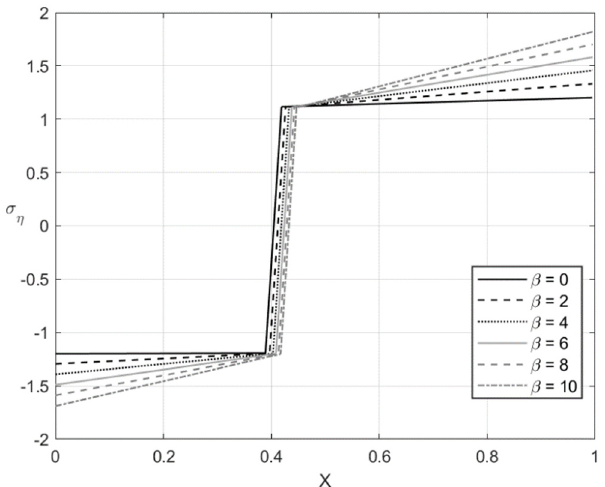
σ = 0.06 H r = at , 0.2 f , and CD